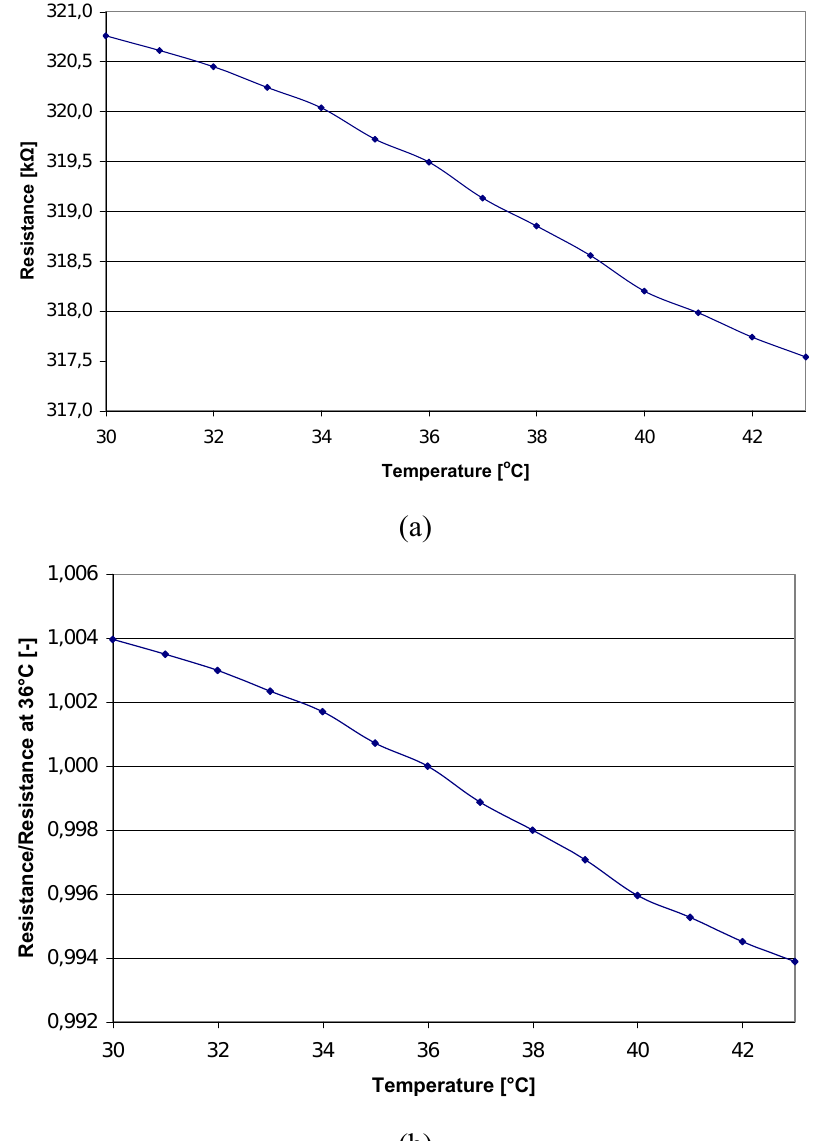
Figure 9. Real (a) and normalized (b) temperature—resistance characteristics of performed polymer elastic temperature sensors, manufactured on single